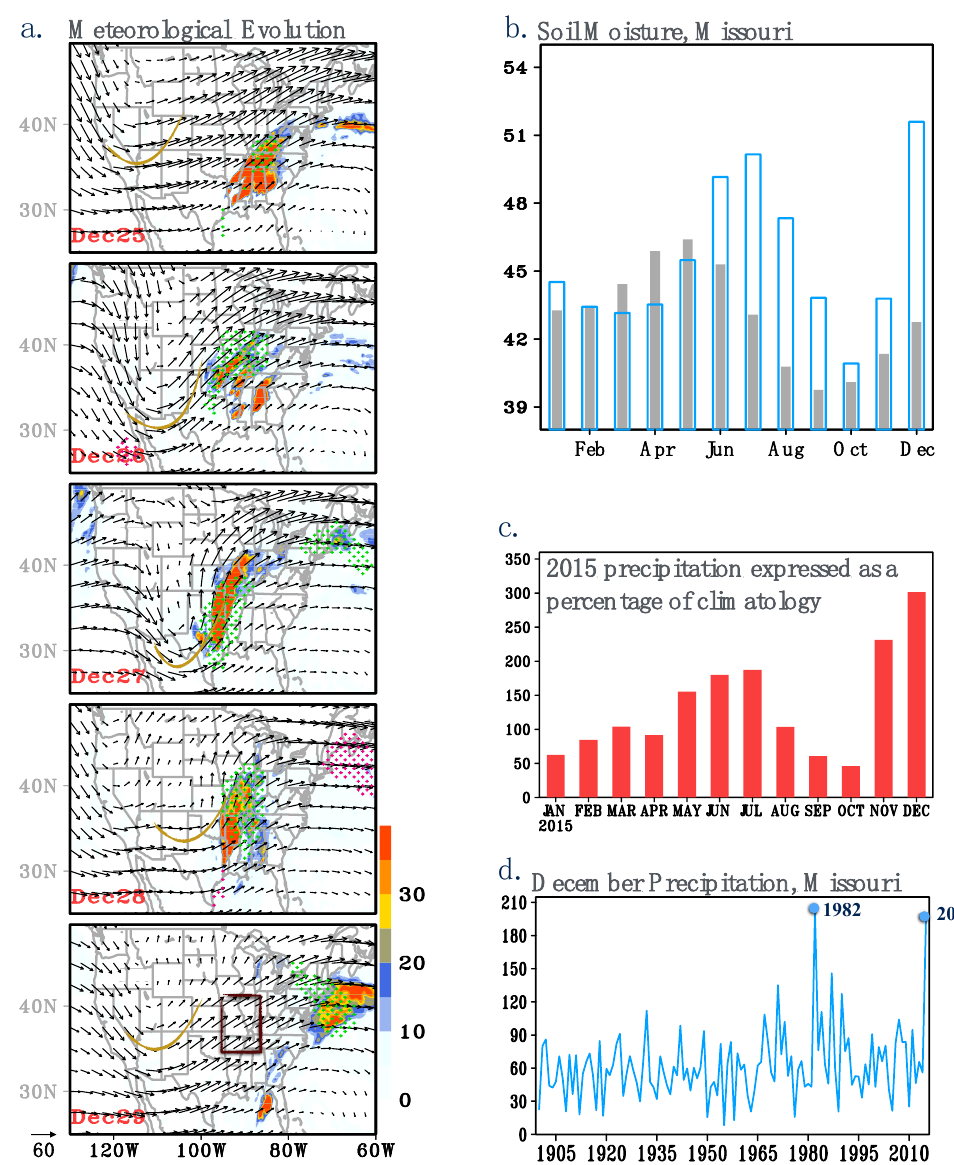
Figure 1. ( a ) Meteorological evolution of the late December event: 250-hPa winds (vectors) and precipitation (mm, shading), from 25–29 December 2015. Areas of positive (negative) vertically integrated (from 1000–300 mb) moisture flux convergence greater than 3 × 10 − 4 kg s − 1 are represented by magenta (green) stippling. Upper-level short wave troughs are marked with yellow curves. The dark red box delineates the most affected storm areas, i.e., the study region; ( b ) 2015 monthly soil moisture (blue outline) (cm) in comparison to the 1950–2010 climatology (gray bars); ( c ) Monthly precipitation in 2015 expressed as a percentage of climatology. Each bar is representative of the total precipitation in each month of 2015 expressed as a percentage of that month’s climatology; ( d ) Interannual variation of statewide monthly precipitation in December for Missouri.